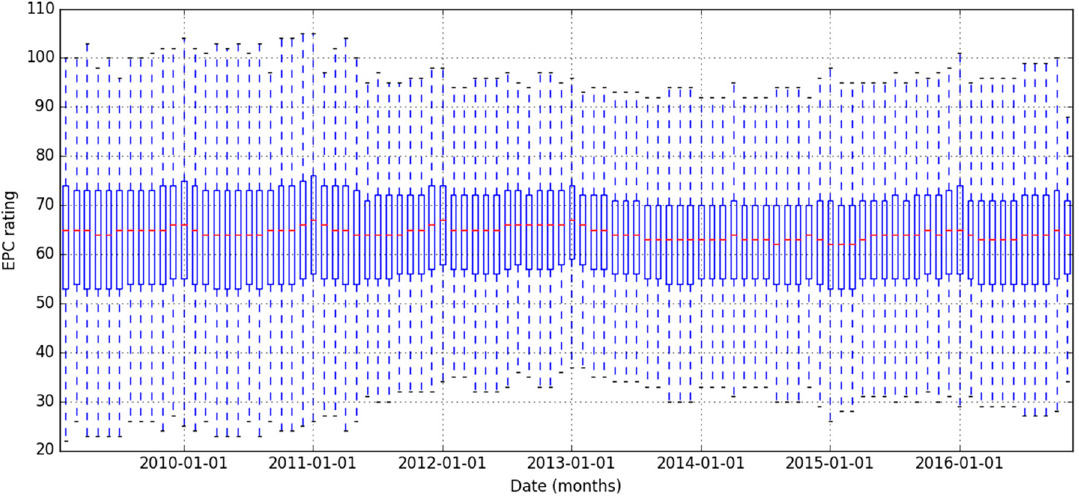
Figure 1. Monthly distributions of EPC ratings from 2009 to 2016. Showing median (red), interquartile range (edges of each box) and 1.5 interquartile ranges above and below the box (edges of whiskers).